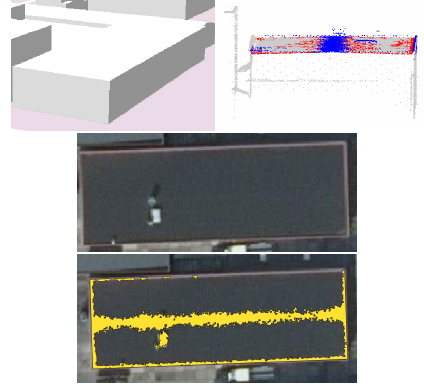
Figure 15. Example of a building that was wrongly reconstructed with a flat roof (top left), leading to the identification of ‘deviations’ (middle and bottom). Settings used: distance threshold 20 cm and angular threshold 5 ◦ . Top right: point cloud - blue: seed points selected based on distance and red: points added during PCA-based region